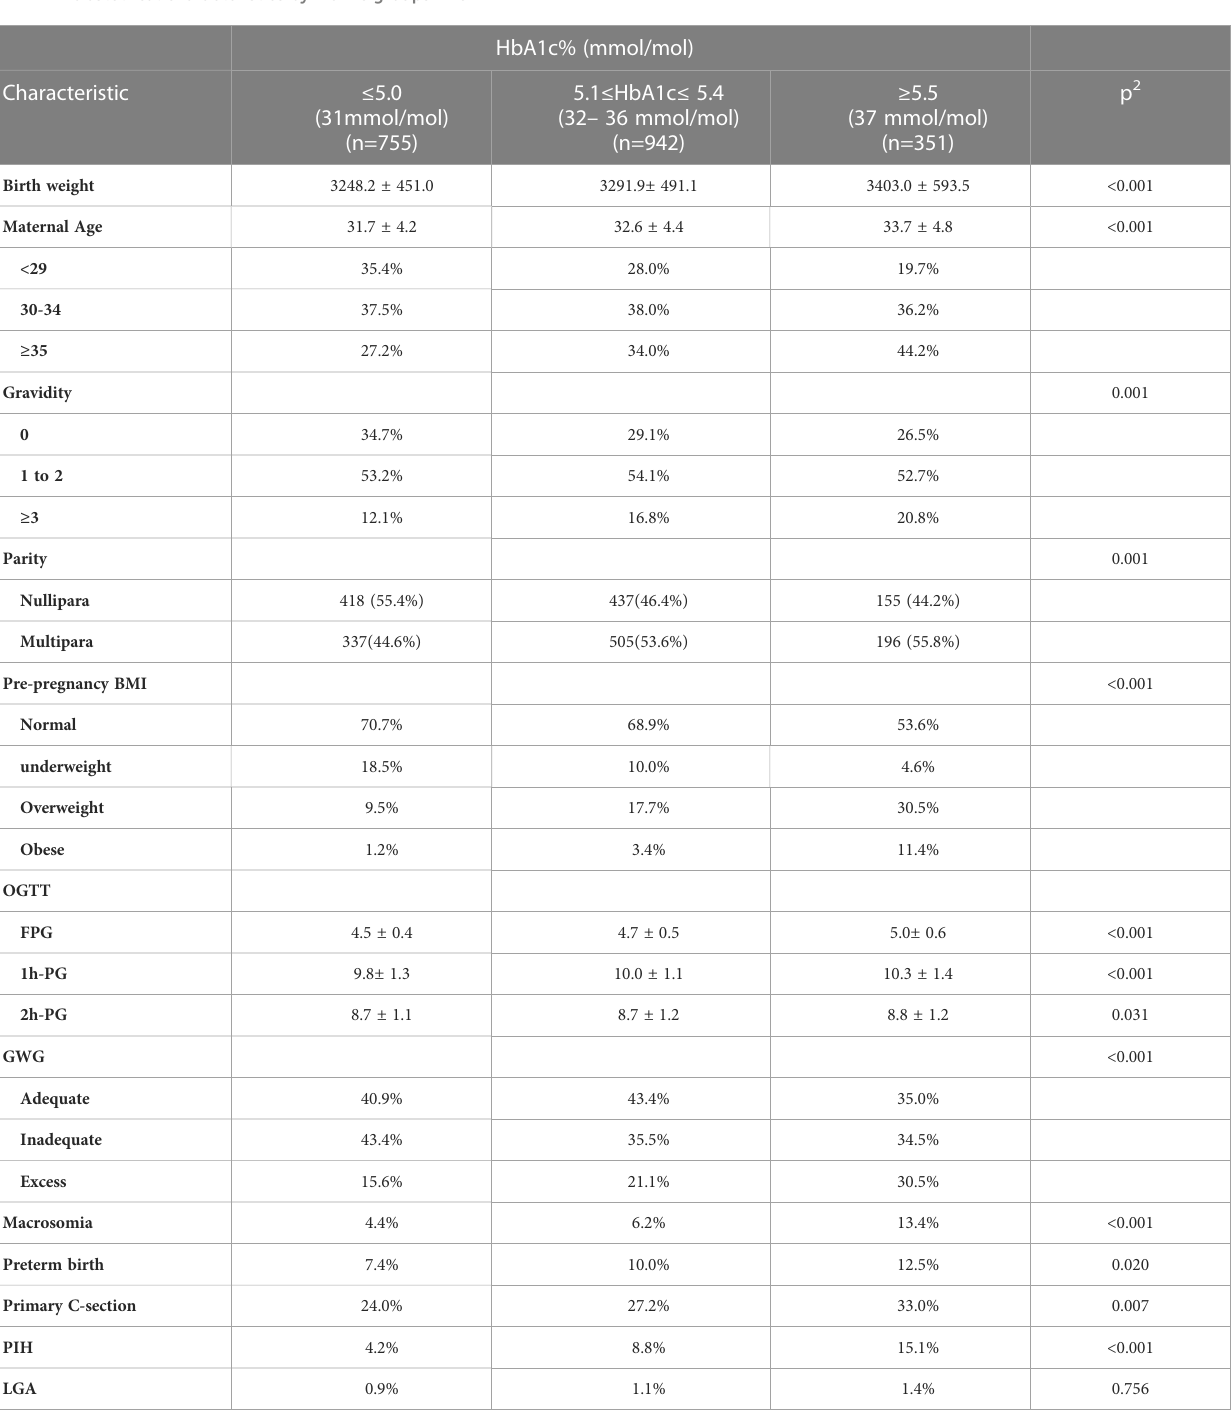
TABLE 1 Obstetrical characteristics by HbA1c groups in GDM 1